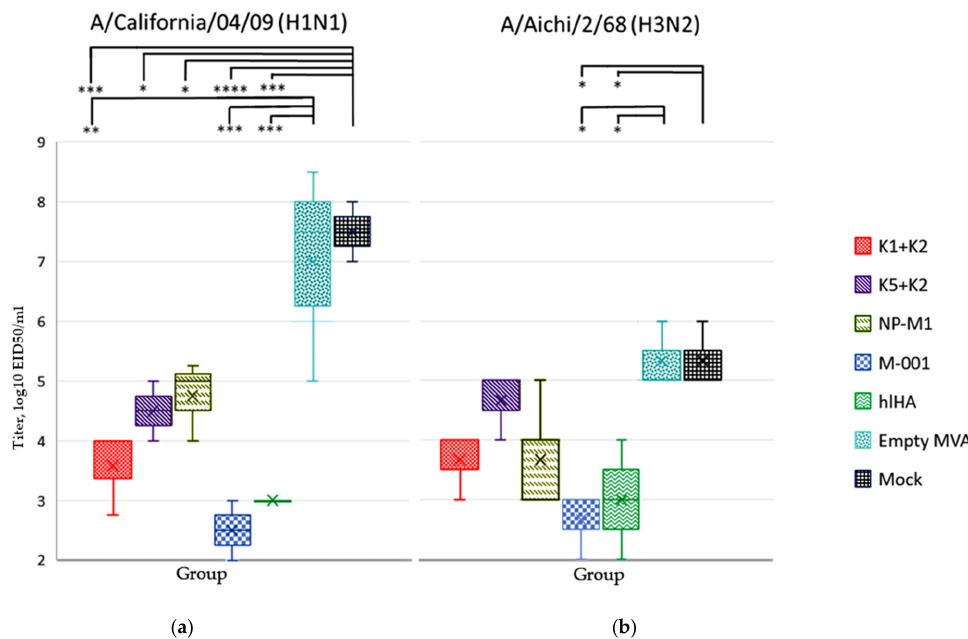
Figure 3. The viral titers (log 10 EID 50 / mL ) in the lungs of mice immunized with rMVAs expressing influenza virus antigens or with wt MVA or PBS after infection with influenza viruses ( a ) A/California/04/09 (H1N1) or ( b ) A/Aichi/2/68 (H3N2). The median ( n = 3) is shown by a bold line inside the boxes. The boxes themselves show the boundaries of the lower and upper quartiles of the distribution covering 50% of the samples, and the ends of the whiskers are the edges of a statistically significant sample (99.3%). The survival rate in each group is indicated at the top. The statistical significance of the differences was assessed using Tukey’s test. Significance: * p -value < 0.05, ** p - value < 0.01, *** p -value < 0.001, **** p -value < 0.0001.